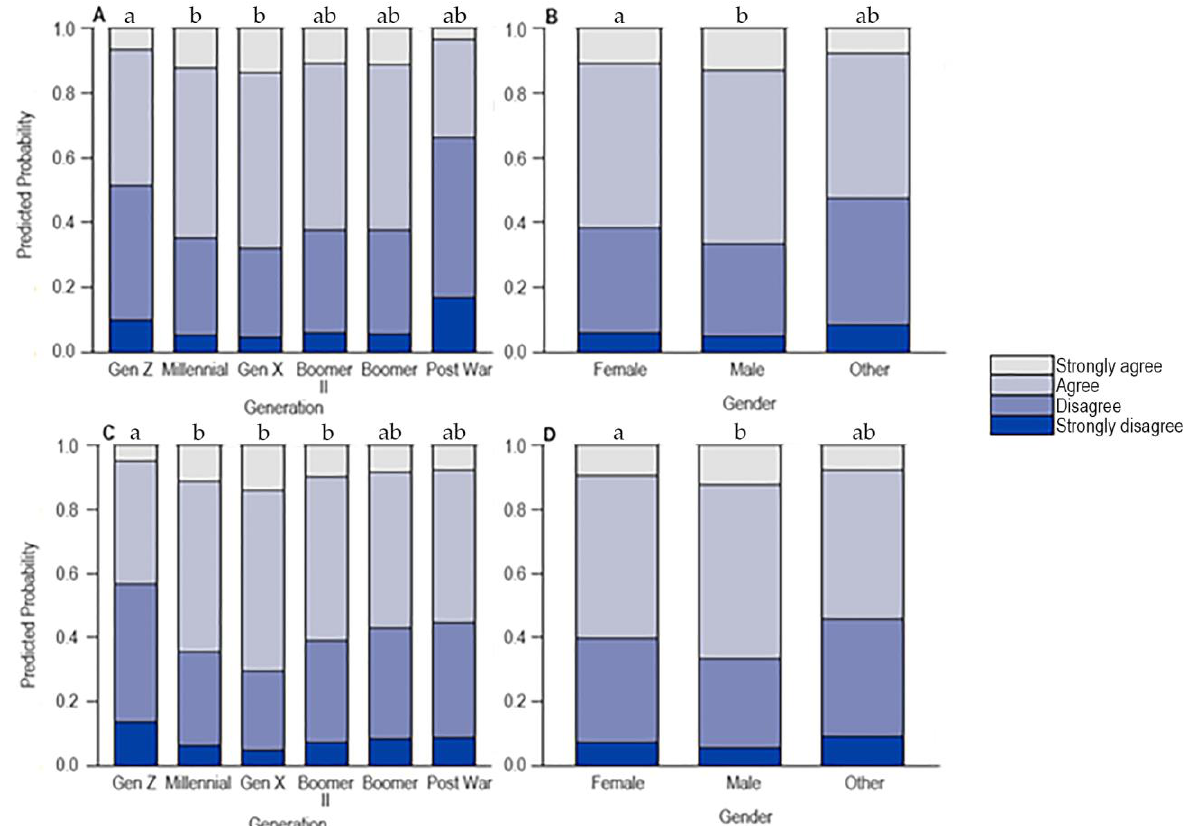
Figure 5. Predictor effect plots for responses to Statement 22 (“Animals in zoos are healthy and comfortable”), showing the effect of ( A ) generation and ( B ) gender for the sloth experiment, and the effect of ( C ) generation and ( D ) gender for the python experiment. In each panel, results are averaged over levels of other predictor variables. Predictor levels that do not share any letter are significantly different ( p < 0.05) as determined by pairwise comparisons conducted using the Tukey method.